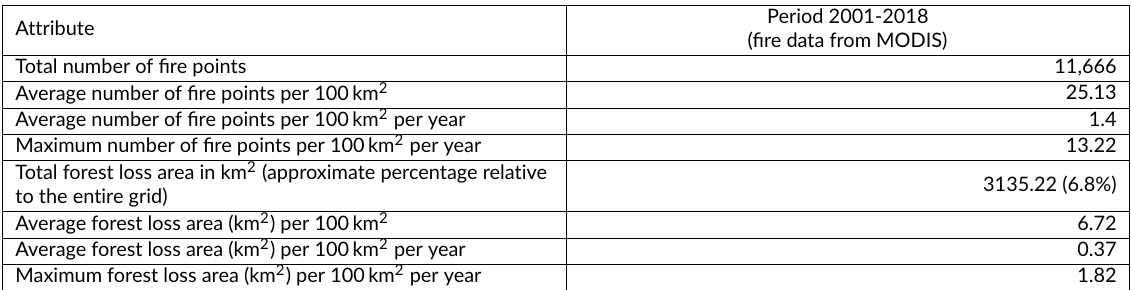
Table 1 – Forest loss and number of fire points within forest cover, summarized using a grid of 482 hexagons, for the period 2001-2018. The baseline year for the forest is 2000 †